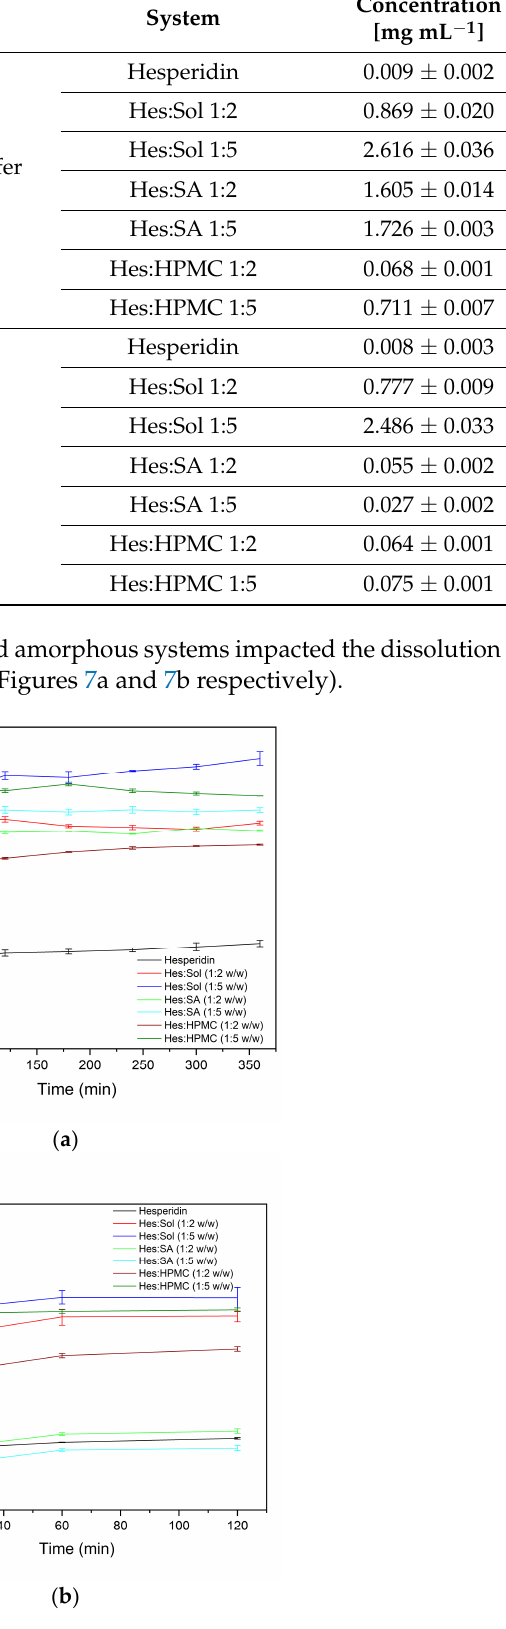
Figure 7. The dissolution profiles of Hes systems’ in ( a ) phosphate buffer and ( b ) HCl.